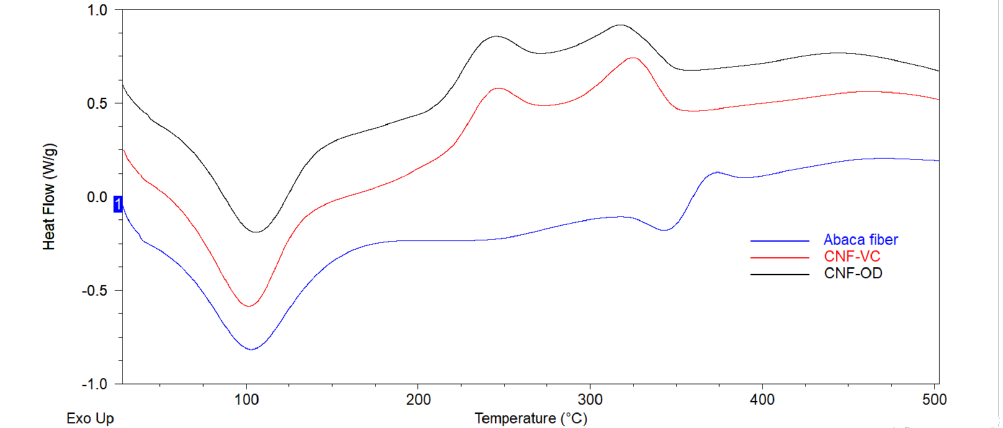
Figure 5. DSC scans of cellulose